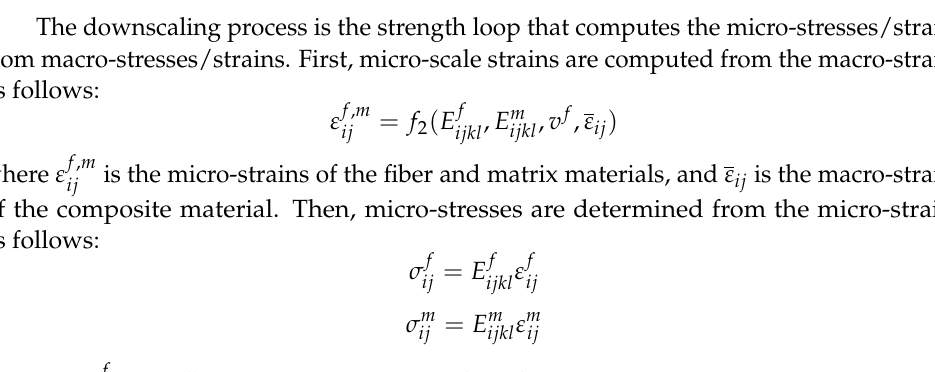
Figure 1. Multiscale analysis of macro- and micro-scales.